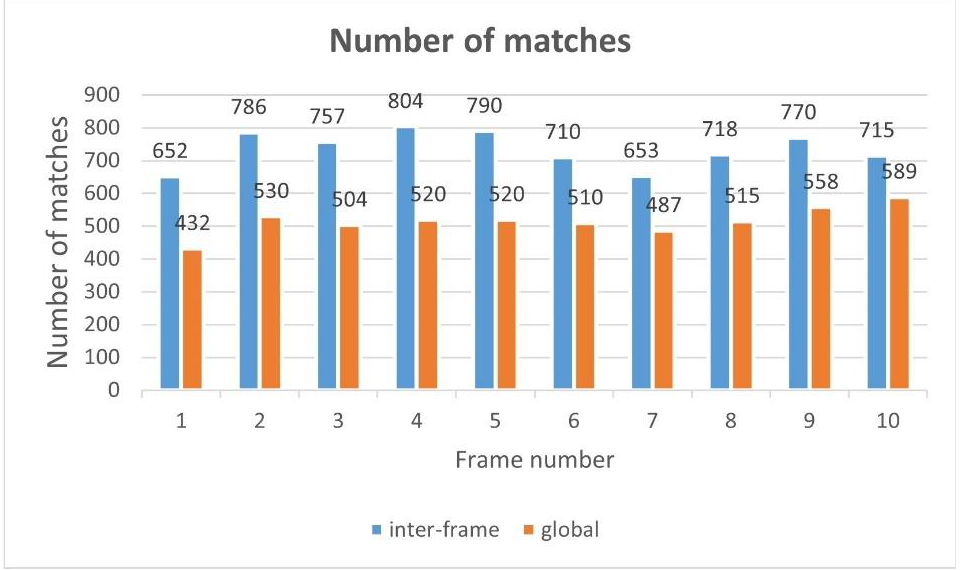
Figure 15. Comparison of the number of matching points with the transformed previous frame and map.